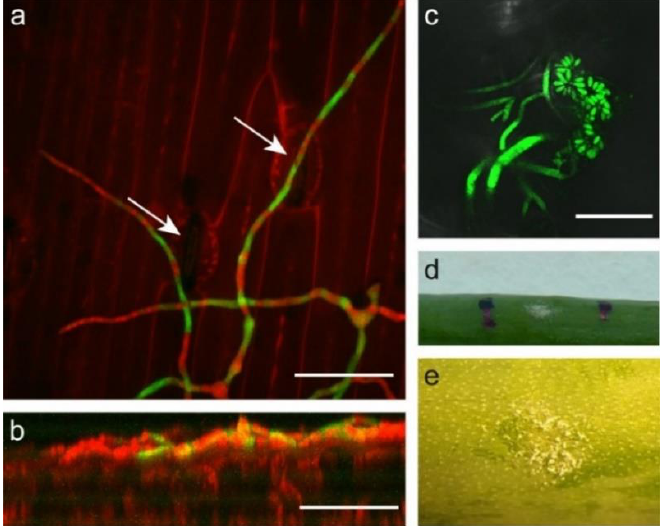
Figure 3. B. aclada on onion leaves. ( a ) Top view and ( b ) front view of a 3D projection of confocal laser scanning microscopy images of hyphae growing over and along stomata of an onion leaf. Scale bars represent 50 µm, arrows indicate stomata, B. aclada —GFP in green and PI-stained onion cell walls in red. Conidiophores with newly formed spores of B. aclada on the surface of an onion leaf observed by ( c ) fluorescence microscopy (scale bar 200 µm), ( d ) on a macroscopic scale, and ( e ) using binocular microscope.